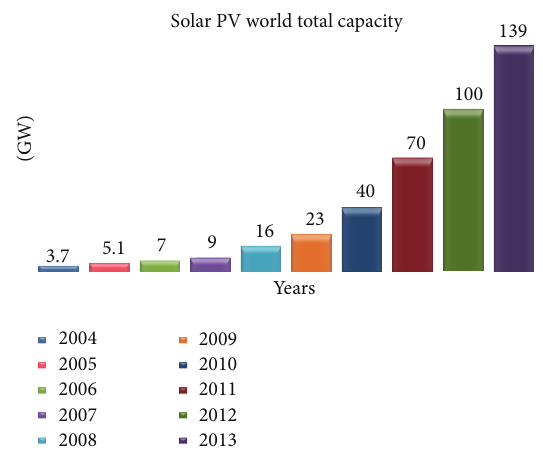
Figure 1: Solar PV, existing world PV capacity, 2004–2014